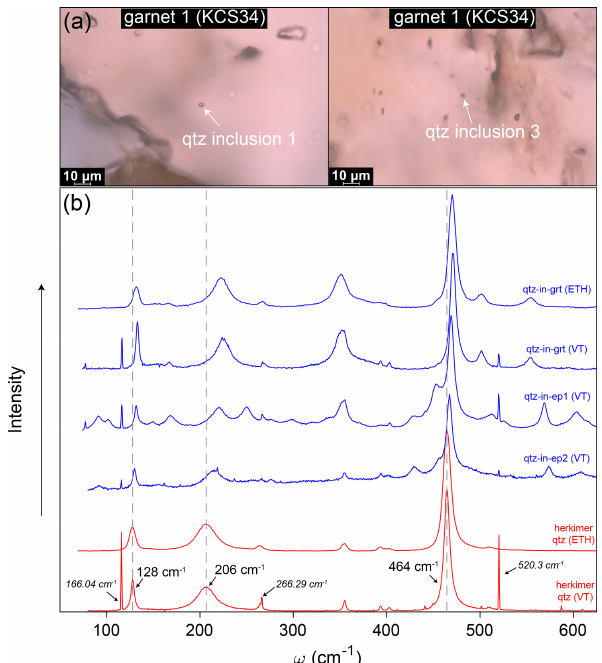
Figure 4. Photomicrographs of measured quartz inclusions in gar- net from Delfini (a) and Raman spectrums of unstrained Herkimer quartz and strained quartz inclusions (b) . (b) Shown for comparison are Herkimer quartz (red) and quartz inclusion (blue) measurements from Virginia Tech and ETH Zürich. Quartz bands and Ar plasma lines (only VT analyses) are numerically